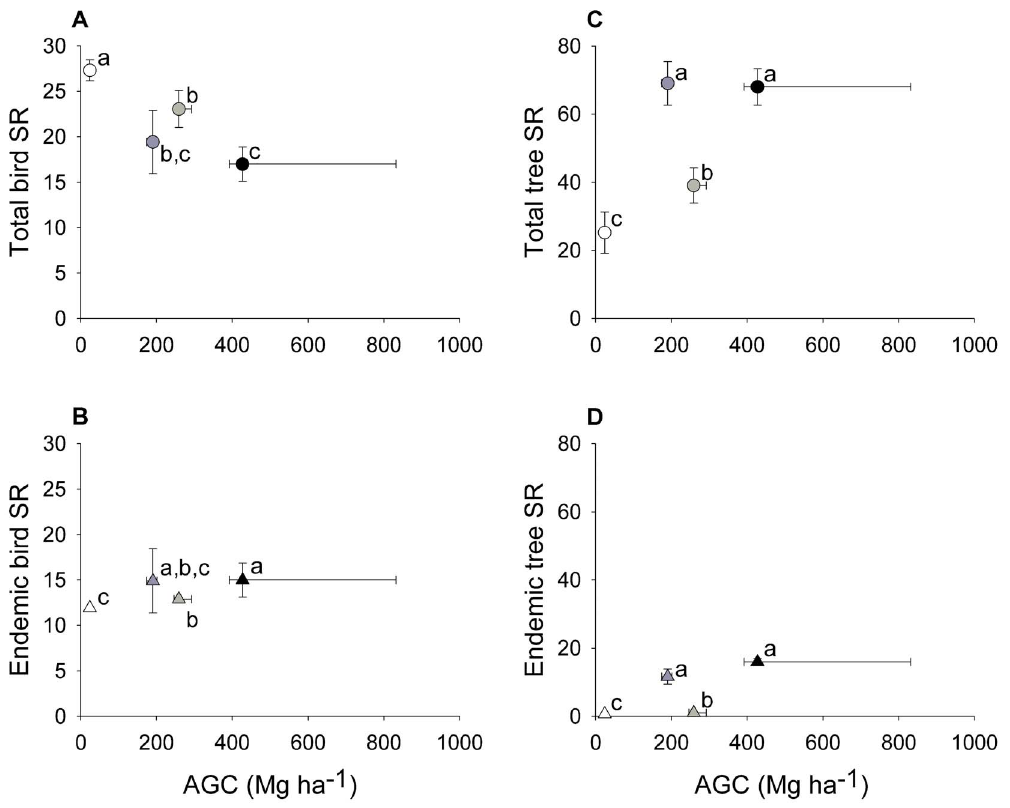
Figure 2. Relationships between aboveground carbon stocks (AGC) and species richness (SR) at the land-use level. The dots’ colours represent land-use; old-growth forest (black), secondary forest (dark grey), shade plantation (light grey) and non-forested (white). Horizontal bars identify the 25 th and 75 th percentile for AGC, while the vertical ones identify the 95% confidence intervals obtained from sample-based rarefaction curves. Small case letters indicate the grouping of land-uses by SR, with a representing the richest and c the poorest. The AGC was significantly higher in old-growth forest than in any other land-use, followed by shade plantation, secondary forest and non-forested land-uses, which was only not significantly smaller from secondary forest.